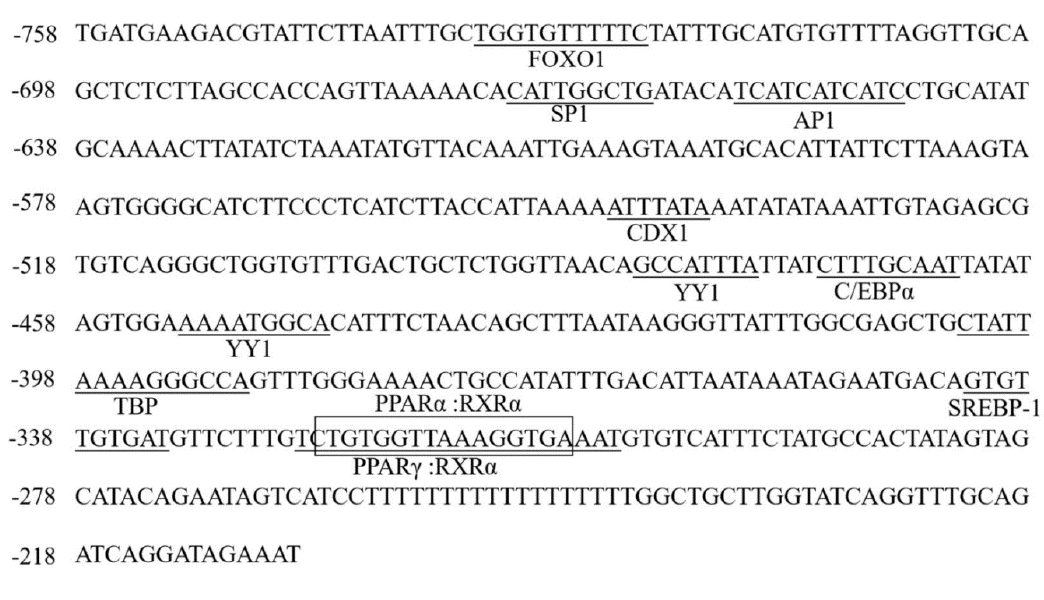
Figure 6. The nucleotide sequence and predicted binding sites for transcription factors in the core region of common carp acsl6 promoter: Numbers are given relative to the first base of the transcription start site (TSS). Potential transcription binding motifs are marked in underline and open boxes for PPARα: RXRα. Details for the name of transcription factors are shown in the text.